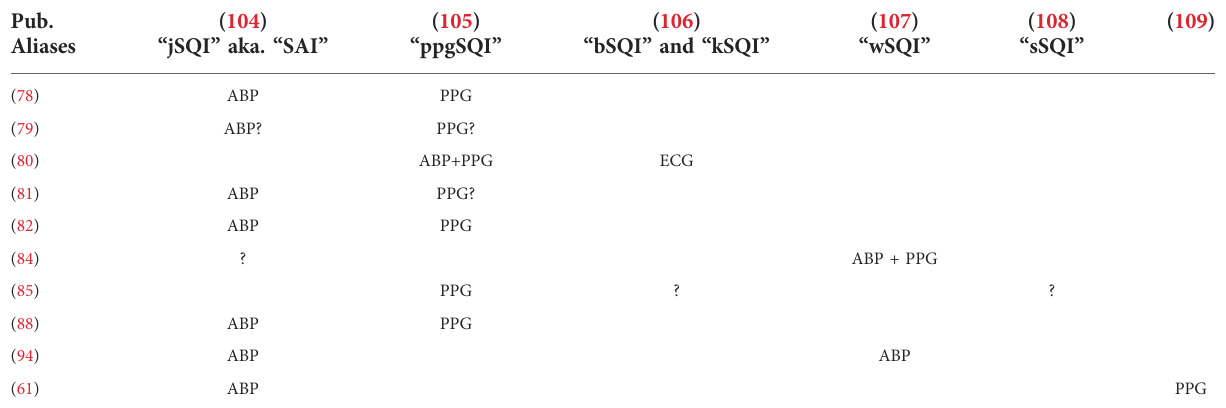
TABLE 5 SQIs used for arrhythmia